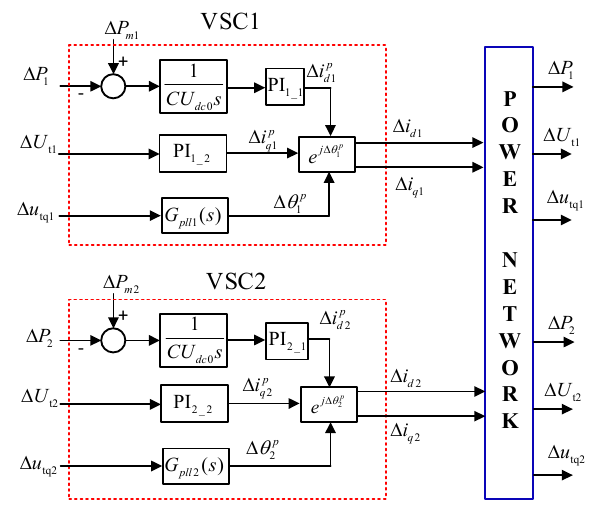
Figure 5. Block diagram of the small ‐ signal model for a weak ‐ grid ‐ connected two ‐ VSC system.